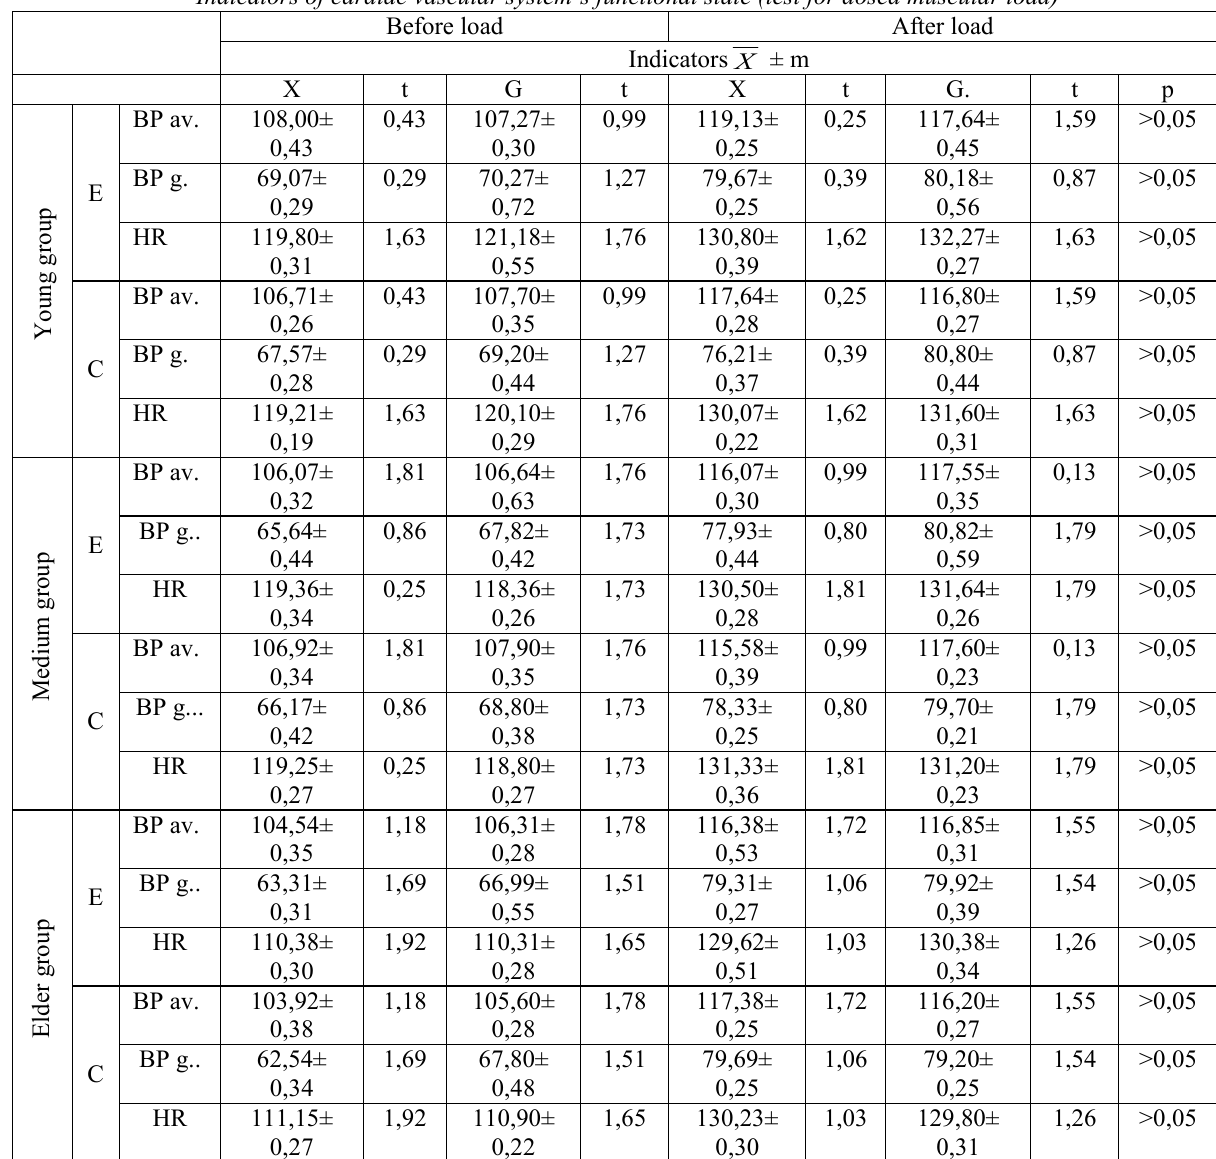
Indicators of cardiac vascular system’s functional state (test for dosed muscular load) Before